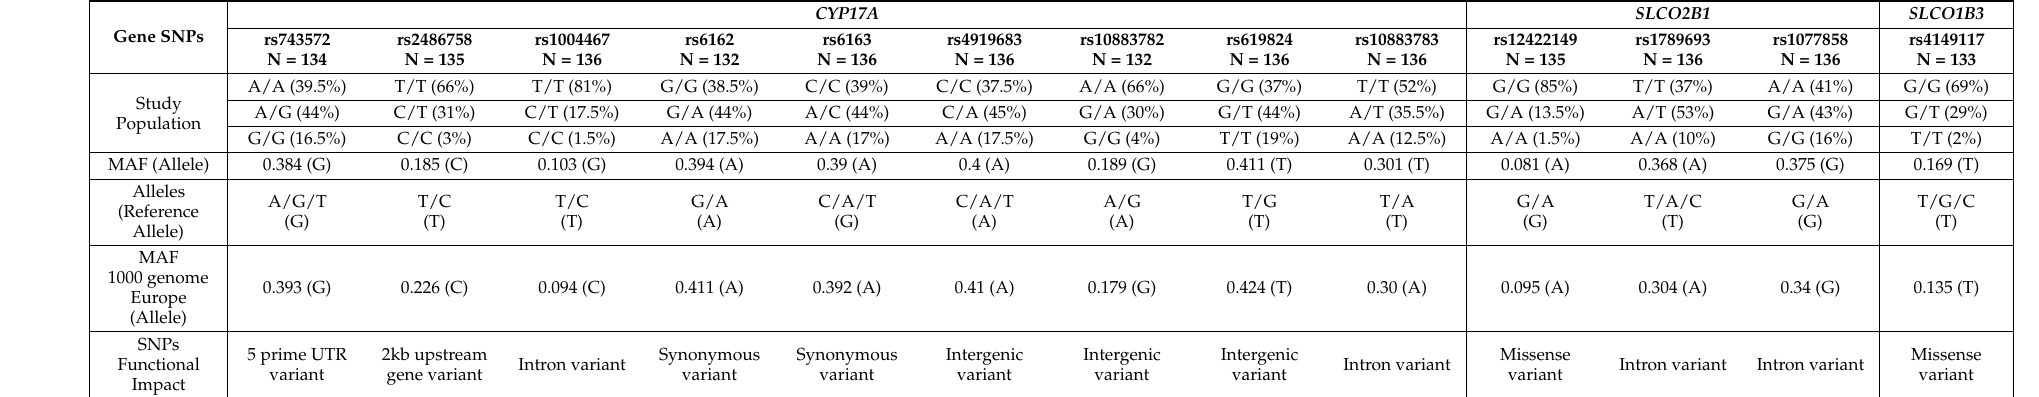
Table keys: SNP = single nucleotide polymorphism; MAF = minor allele frequency. Table 3. Correlations between study SNPs and progression-free survival and